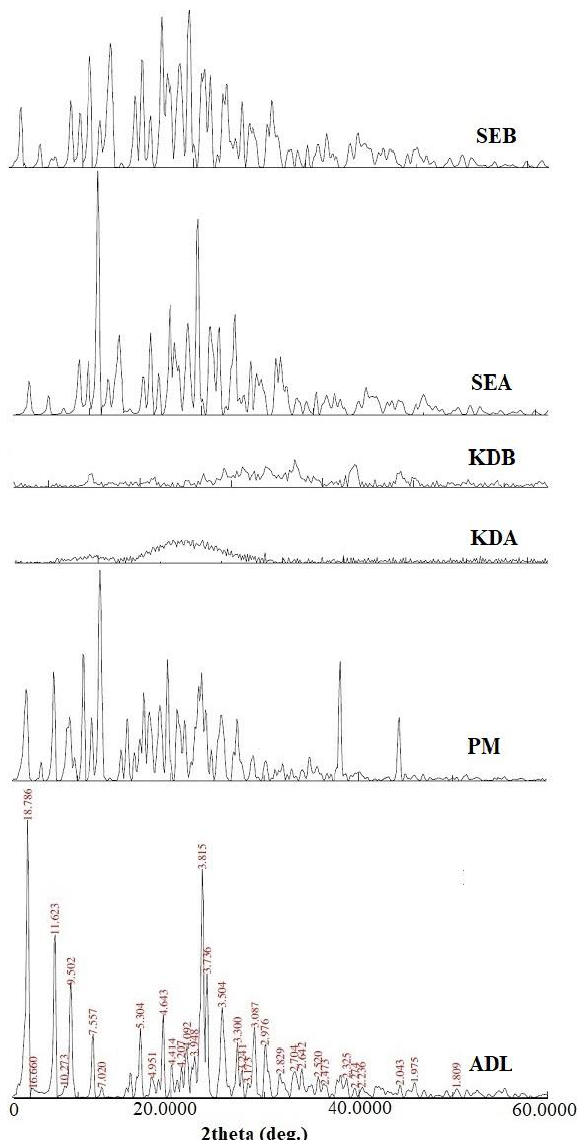
Figure 5. Comparative PXRD spectra of pure ADL, the PM and their binary and ternary complexes. Physical mixture (PM); binary kneaded ADL/ β -CD (KDA); ternary kneaded ADL/ β -CD with 1% poloxamer 188 (KDB); binary solvent evaporated ADL/ β -CD (SEA); ternary solvent evaporated ADL/ β -CD with 1% poloxamer 188